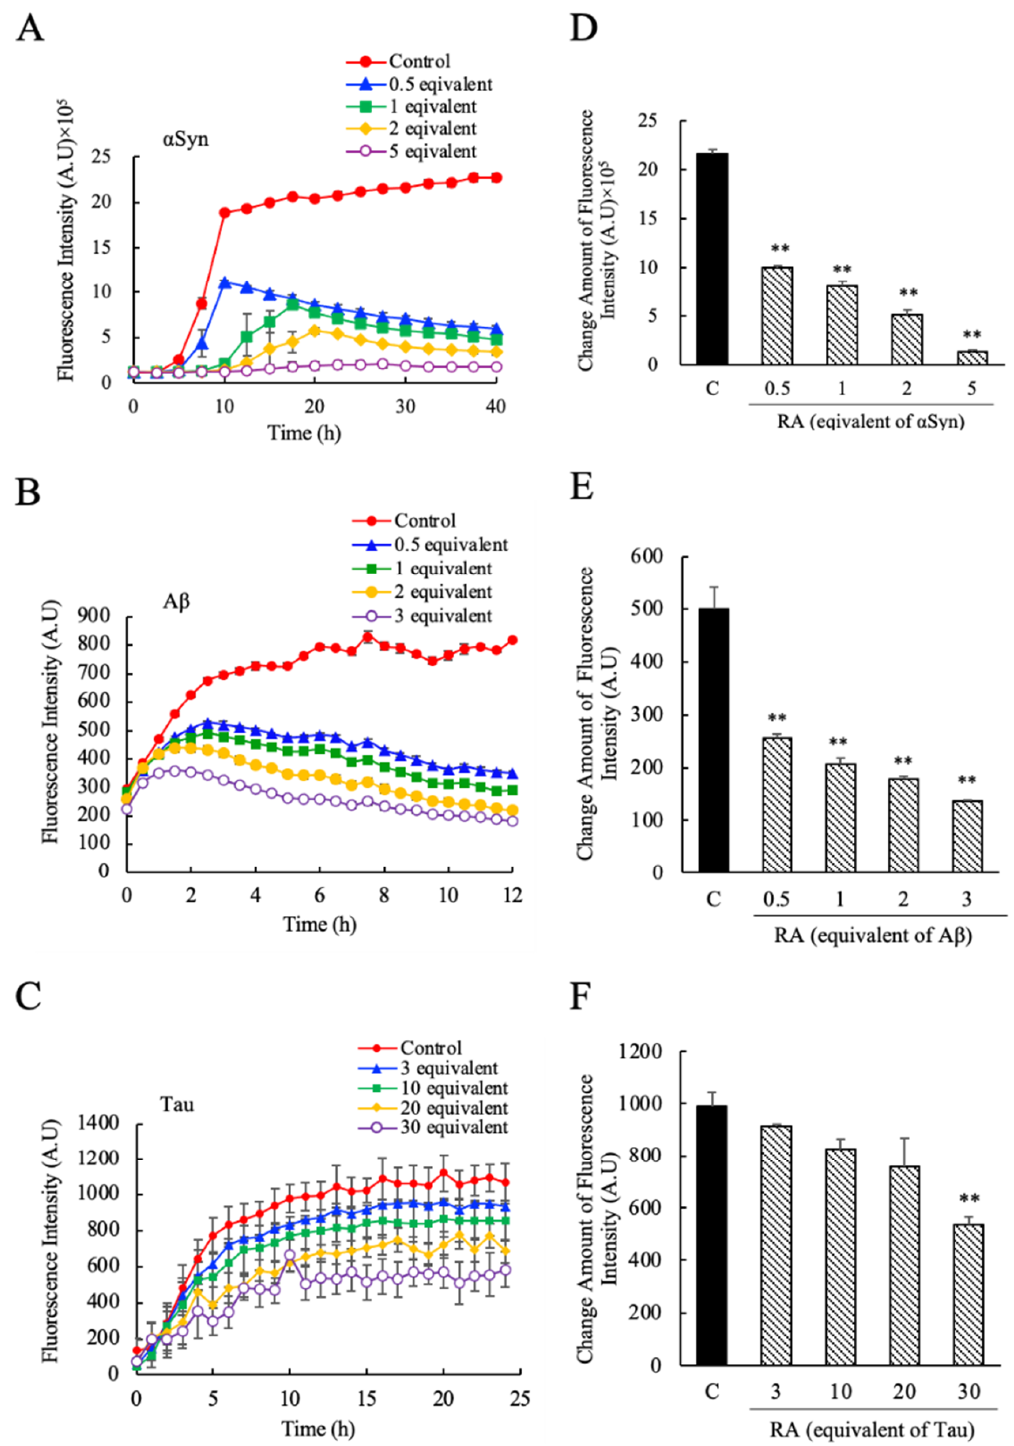
Figure 3. The inhibitory effects of pure rosmarinic acid (RA) against α-synuclein (αSyn), amyloid beta (Aβ), and Tau amyloid fibril formation. The degree of amyloid fibril formation was detected over time by measuring ThioT fluorescence in the presence and absence of pure RA; ( A ) αSyn (0.5–5 equivalent-mol RA), ( B ) Aβ (0.5–3 equivalent-mol RA), ( C ) Tau (3–30 equivalent-mol RA). The net amount of fluorescence intensity change was estimated by the ratio between the maximum value and initial measurement value of its intensity; ( D ) αSyn, ( E ) Aβ, ( F ) Tau. Data are means ± SEM ( n = 3). C, control. ** p < 0.01 vs. the control group (Dunnett’s multiple comparison test).